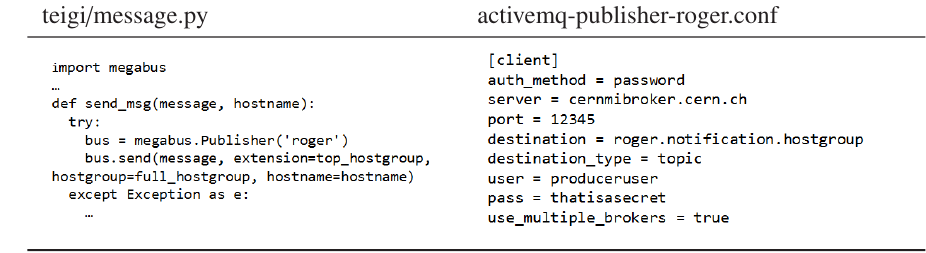
Table 1. Roger sending state update via CERNMegabus to the CERN IT MI